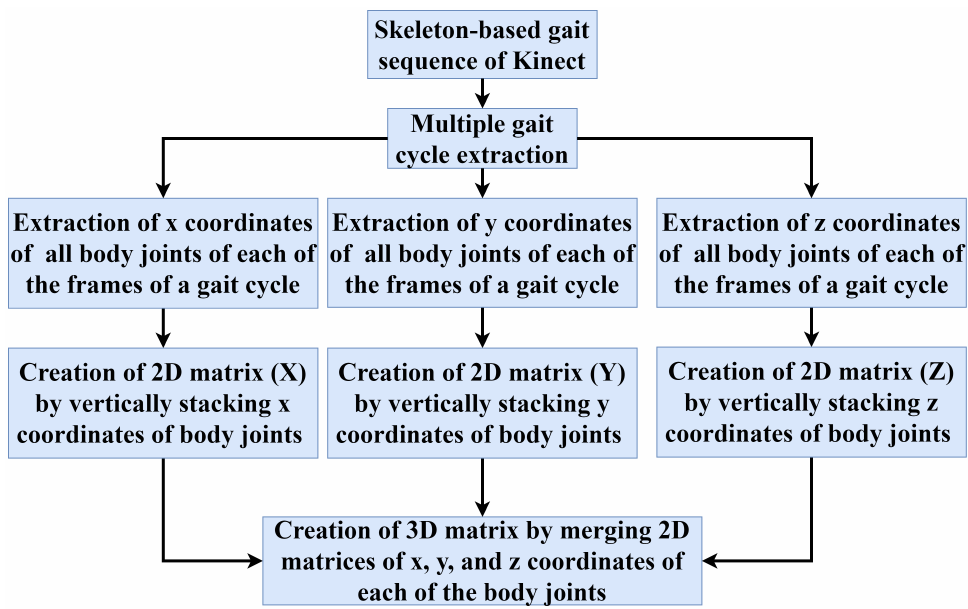
Figure 3. Flowchart of a 3D matrix generation from the body joints over the frames of a gait